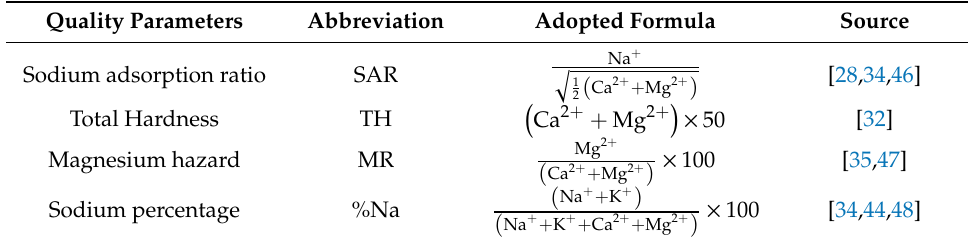
Table 2. Estimation methods for computation of irrigation water suitability (Sources modified by researchers [32,35,45]).